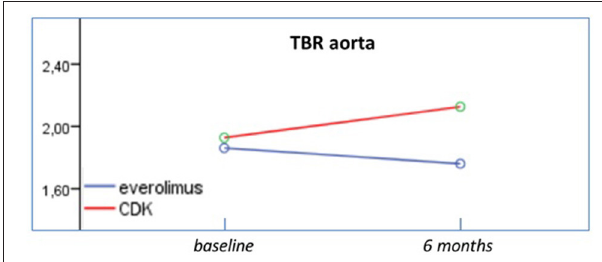
remained stable at follow up.